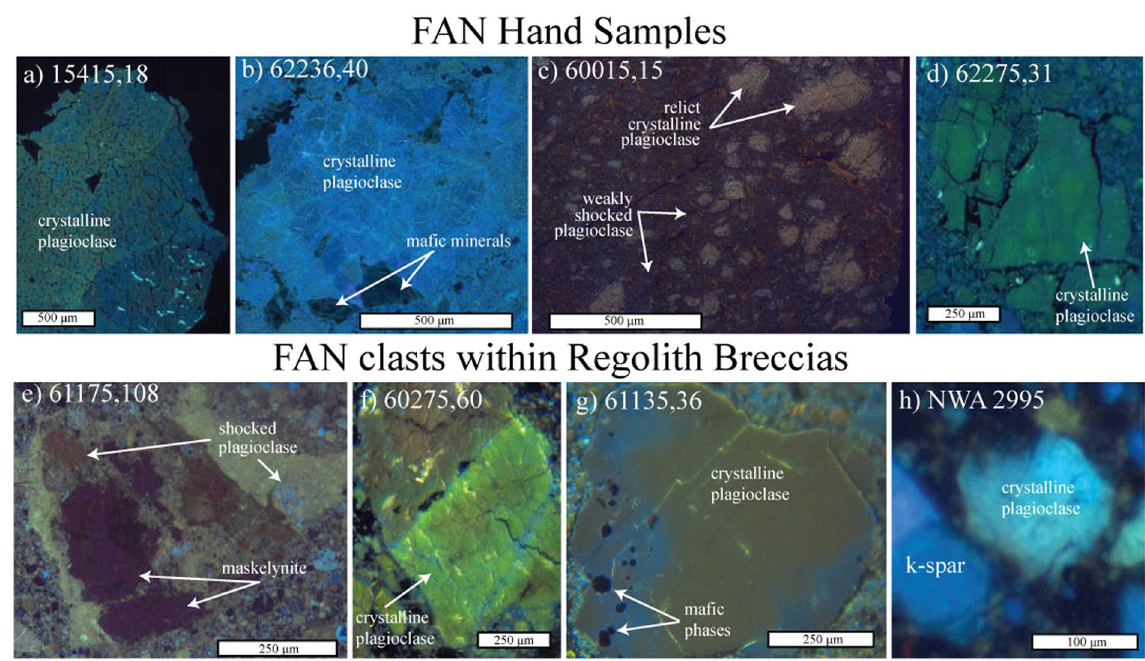
Figure 5. Representative CL-images for both Apollo FAN hand samples ( A – D ) and regolith clasts ( E – H ). Plagioclase displaying blue/green/orange CL emissions are indicative of plagioclase feldspar. In some cases, CL emission zoning is observed ( G ). Dark inky-blue emissions are indicative of high shock states > ~15 Ga ( E